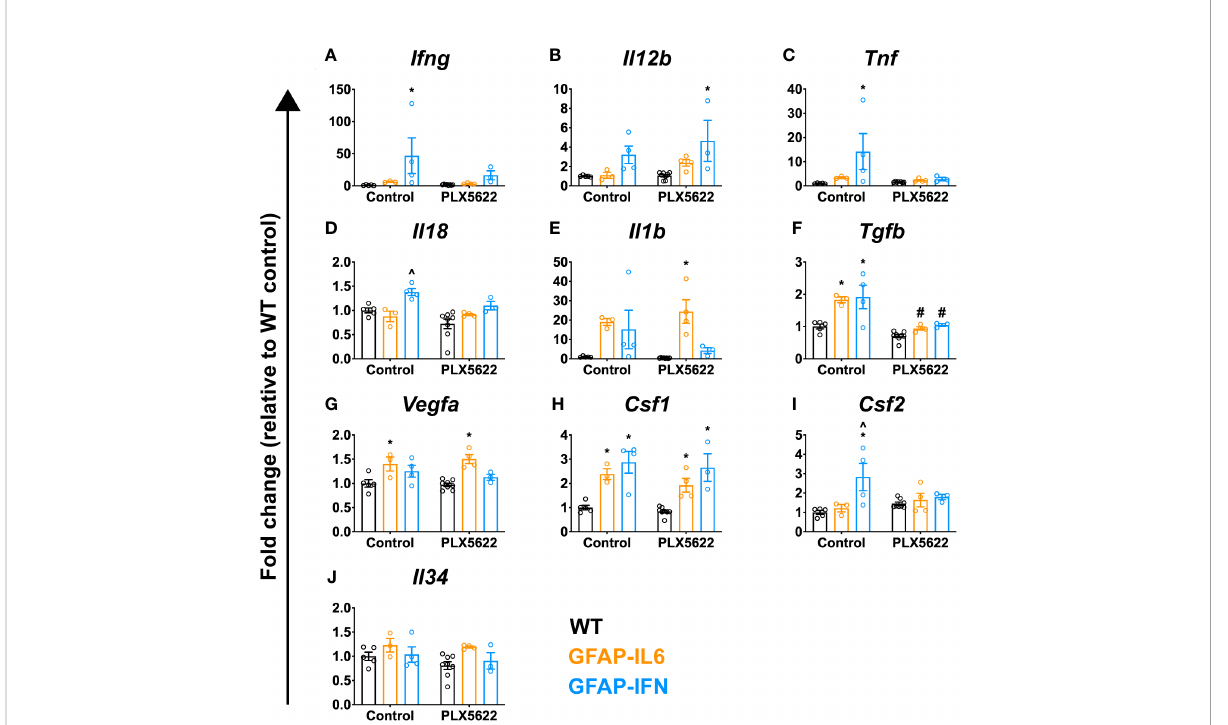
FIGURE 7 PLX5622-mediated ablation of microglia in the brain of GFAP-IL6 and GFAP-IFN mice does not result in enhanced cytokine gene expression. (A – J) qPCR of selected cytokine genes in the cerebellum of WT, GFAP-IL6 and GFAP-IFN mice treated with control or PLX5622 diet for 12 weeks. Fold change of the cytokine genes (A) Ifng , (B) Il12b (IL-12 p40), (C) Tnf , (D) Il18 , (E) Il1b , (F) Tgfb , (G) Vegfa , (H) Csf1 , (I) Csf2 and (J) Il34 . n=3-8 mice/group. Graphs show individual values per mouse and mean ± SEM. *p<0.05 compared with WT of same condition; ^p<0.05 compared with GFAP-IL6 of same condition; # p<0.05 compared with untreated control of same genotype using two-way ANOVA with Tukey ’ s